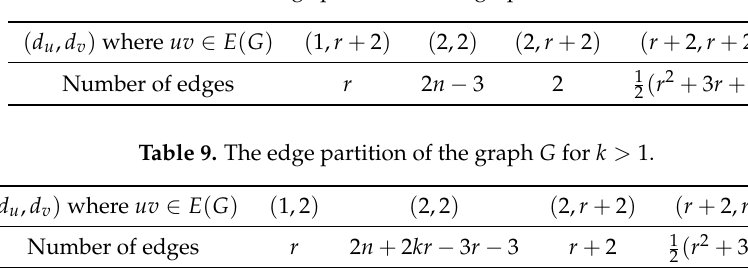
Table 8. The edge partition of the graph G for k = 1.